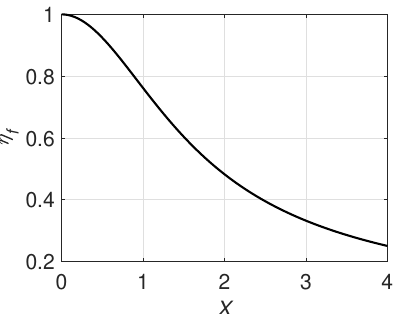
Figure 8. Graphic definition of the